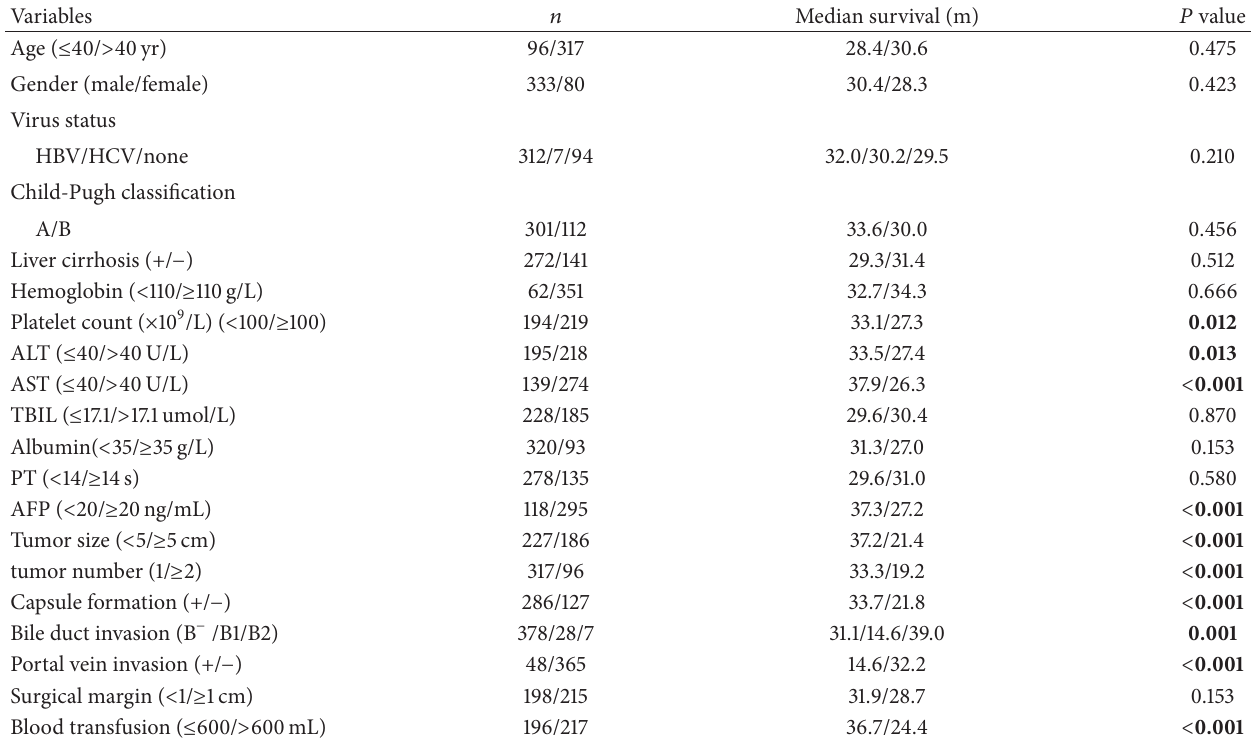
Table 3: Univariate analysis of risk factors for prognosis of HCC after surgical resection.